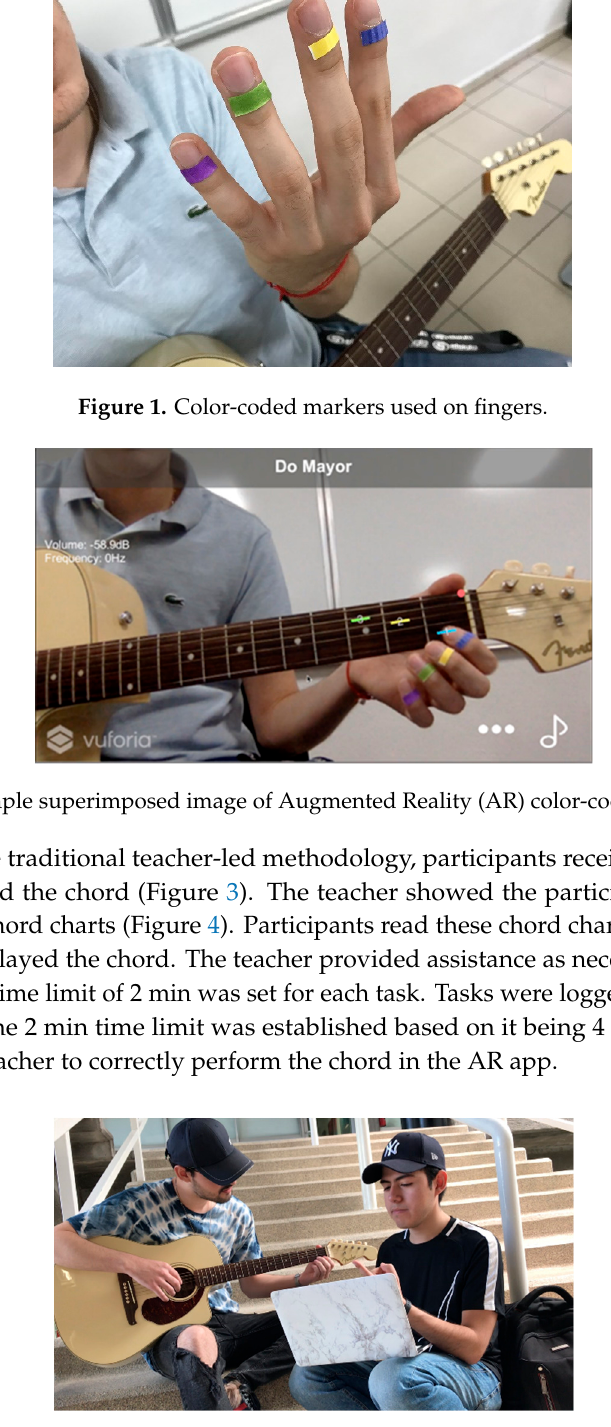
Figure 3. Evaluation in the traditional methodology.